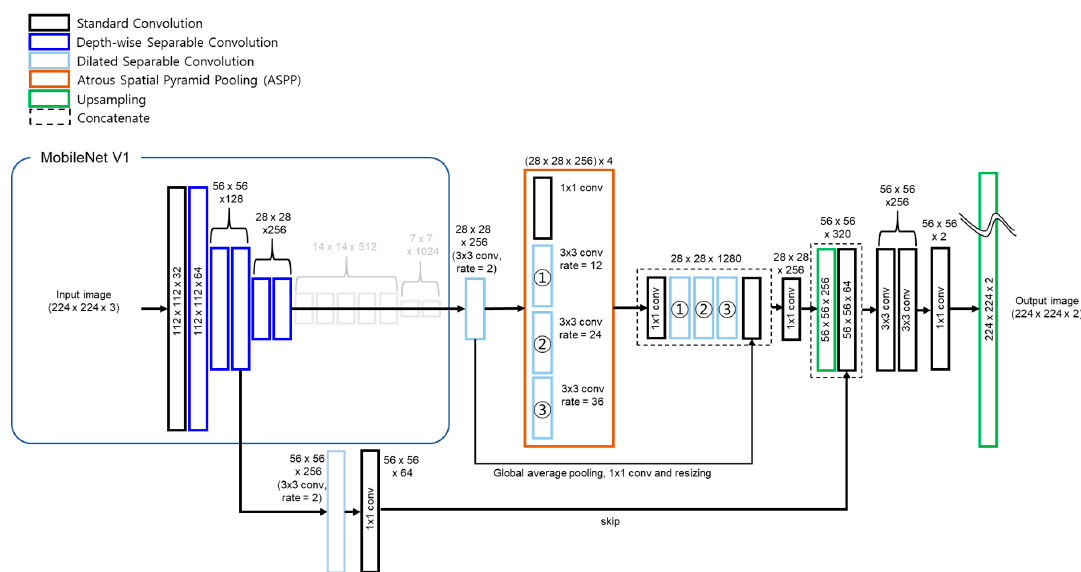
Figure 4. Model architecture of DeepLabV3.